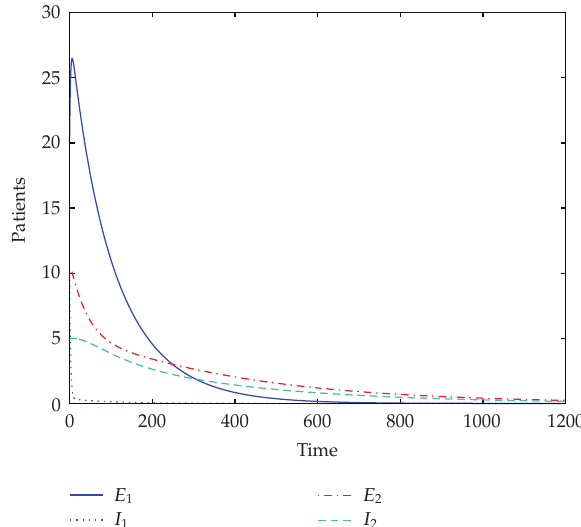
Figure 4: Trajectories of system (cid:2) 2.2 (cid:3) when β 1 (cid:2) N (cid:3) (cid:8) β 1 C (cid:2) N (cid:3) , β 2 (cid:2) N (cid:3) (cid:8) β 2 C (cid:2) N (cid:3) , C (cid:2) N (cid:3) (cid:8) N/ (cid:2) 1 (cid:9) N (cid:9) √ 1 (cid:9) 2 N (cid:3) , β 1 (cid:8) 0 . 001, β 2 (cid:8) 0 . 0001, d 1 (cid:8) d 2 (cid:8) 0, so that R 1 < 1, R 2 < 1. It shows that the disease-free equilibrium P 0 is